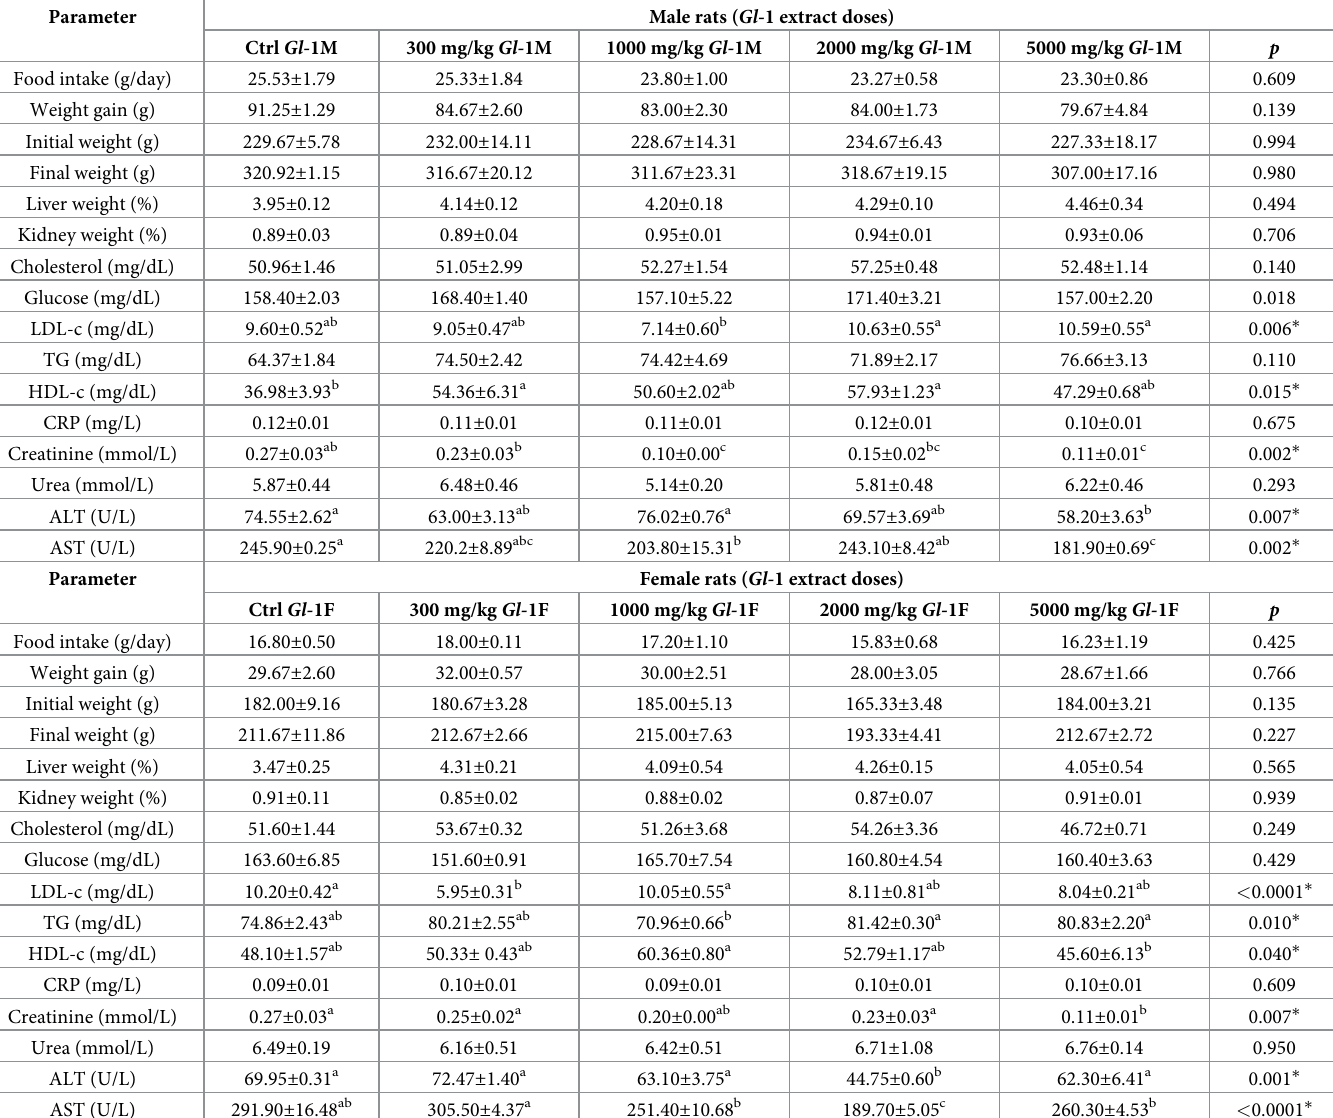
Table 1. Average data from food intake, weight gain, liver and kidney weight, and serum biochemical parameters of male (M) and female (F) Wistar rats studied, after 14 experimental days. Rats were fed with the control diet and different doses of the standardized Gl -1 extract from Ganoderma lucidum .